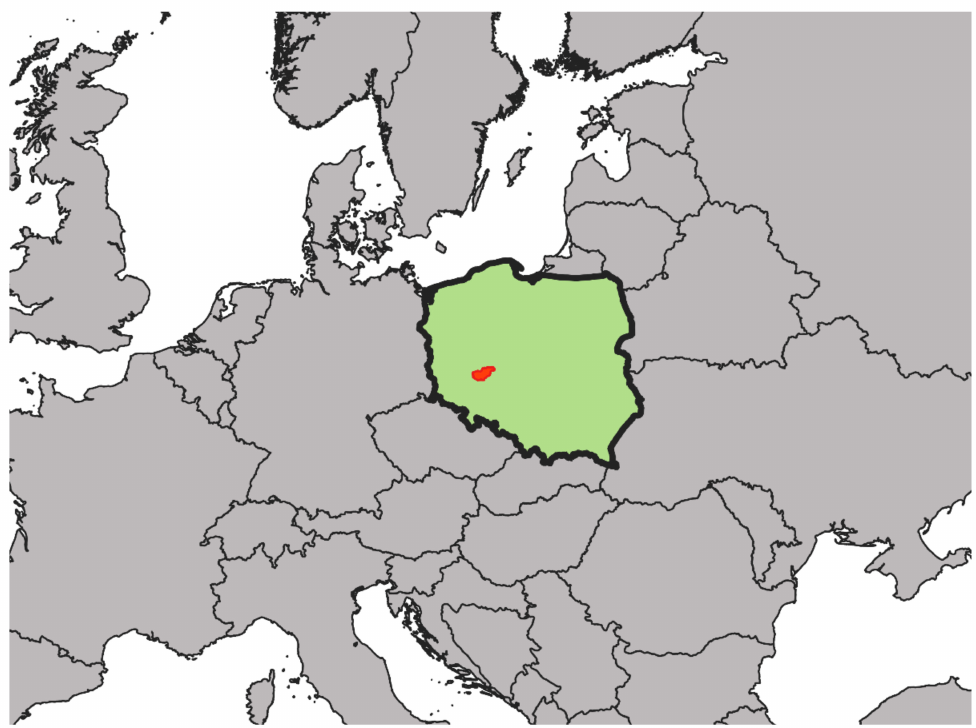
Figure 1. Location of the Orla River catchment area in comparison to Poland and neighboring